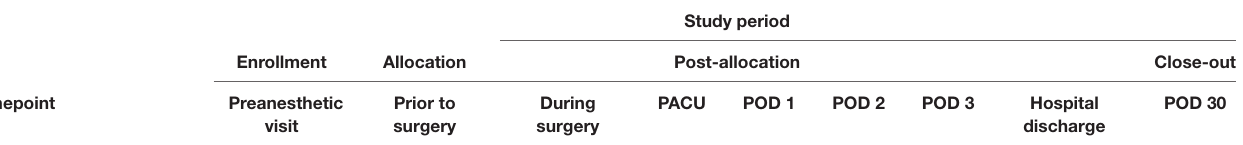
TABLE 1 | Schedule of enrollment, interventions, and assessments.